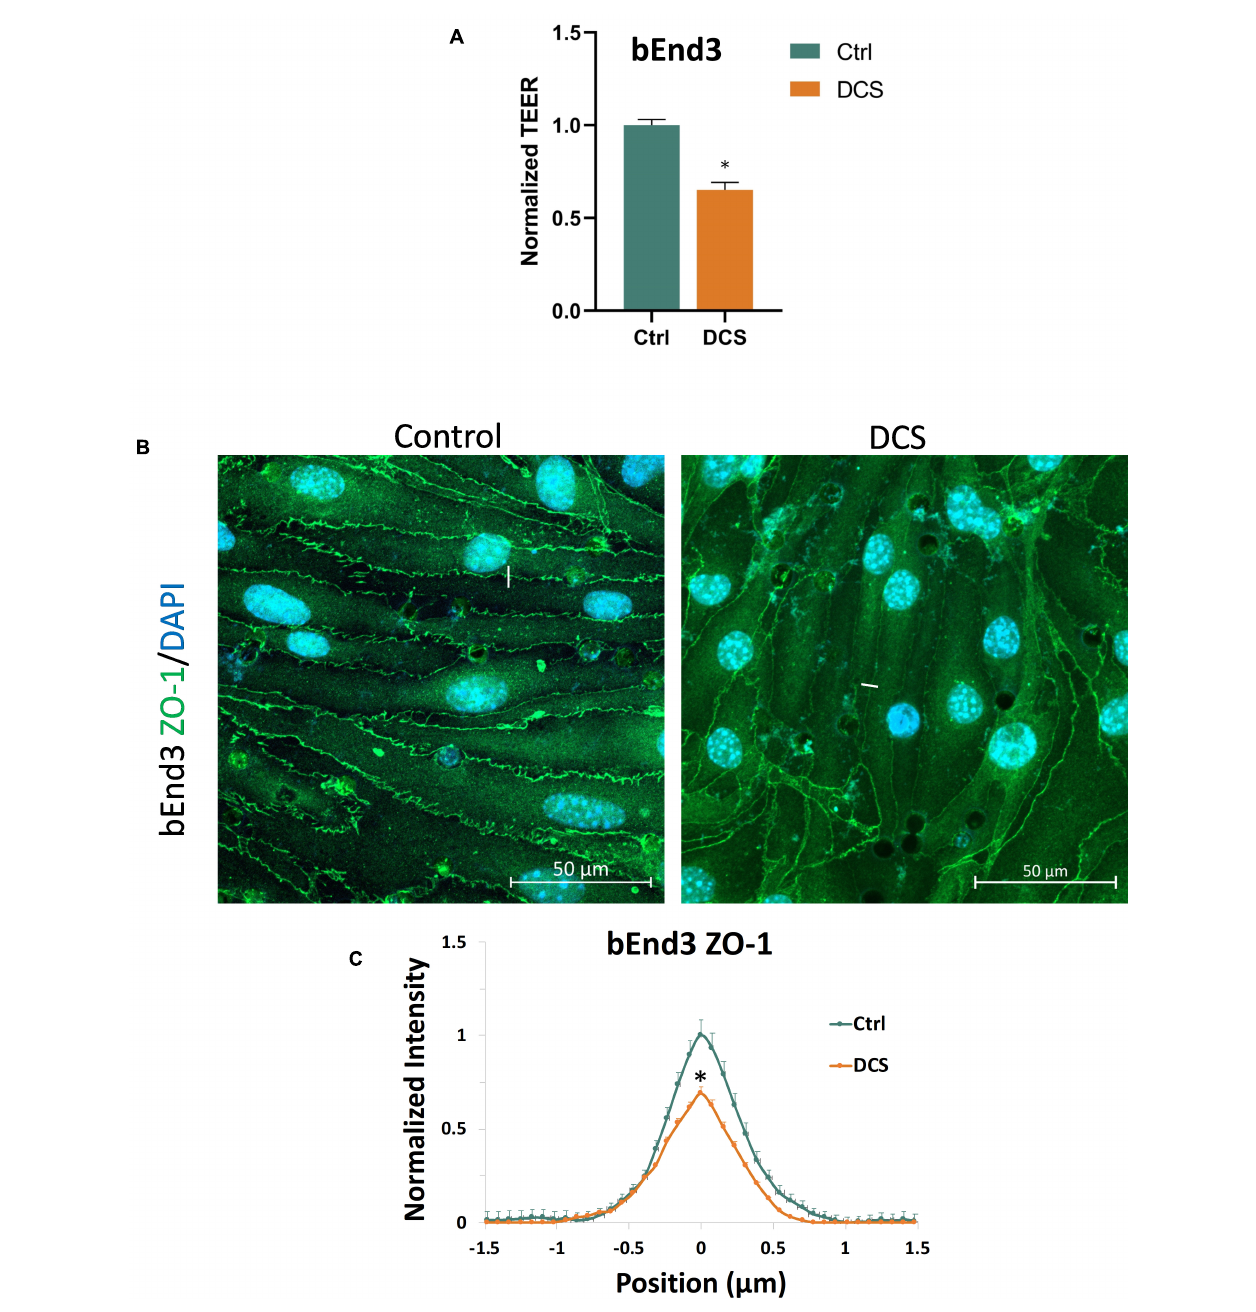
FIGURE 7 | Effects of DCS on TEER and tight junction protein ZO-1 of in vitro BBB formed by bEnd3 monolayer. (A) Normalized TEER, (B) confocal images of ZO-1 of in vitro BBB, and (C) comparison of the intensity profiles of ZO-1 along a ∼ 3 µ m line perpendicular to the EC junctions (white lines in the confocal images) under control and after 10 min treatment with 1 mA/cm 2 DCS. The peak intensity of ZO-1 from the control was used for the normalization. n = 120 profiles for junctions between 30 ECs were averaged for each plot. ∗ p <